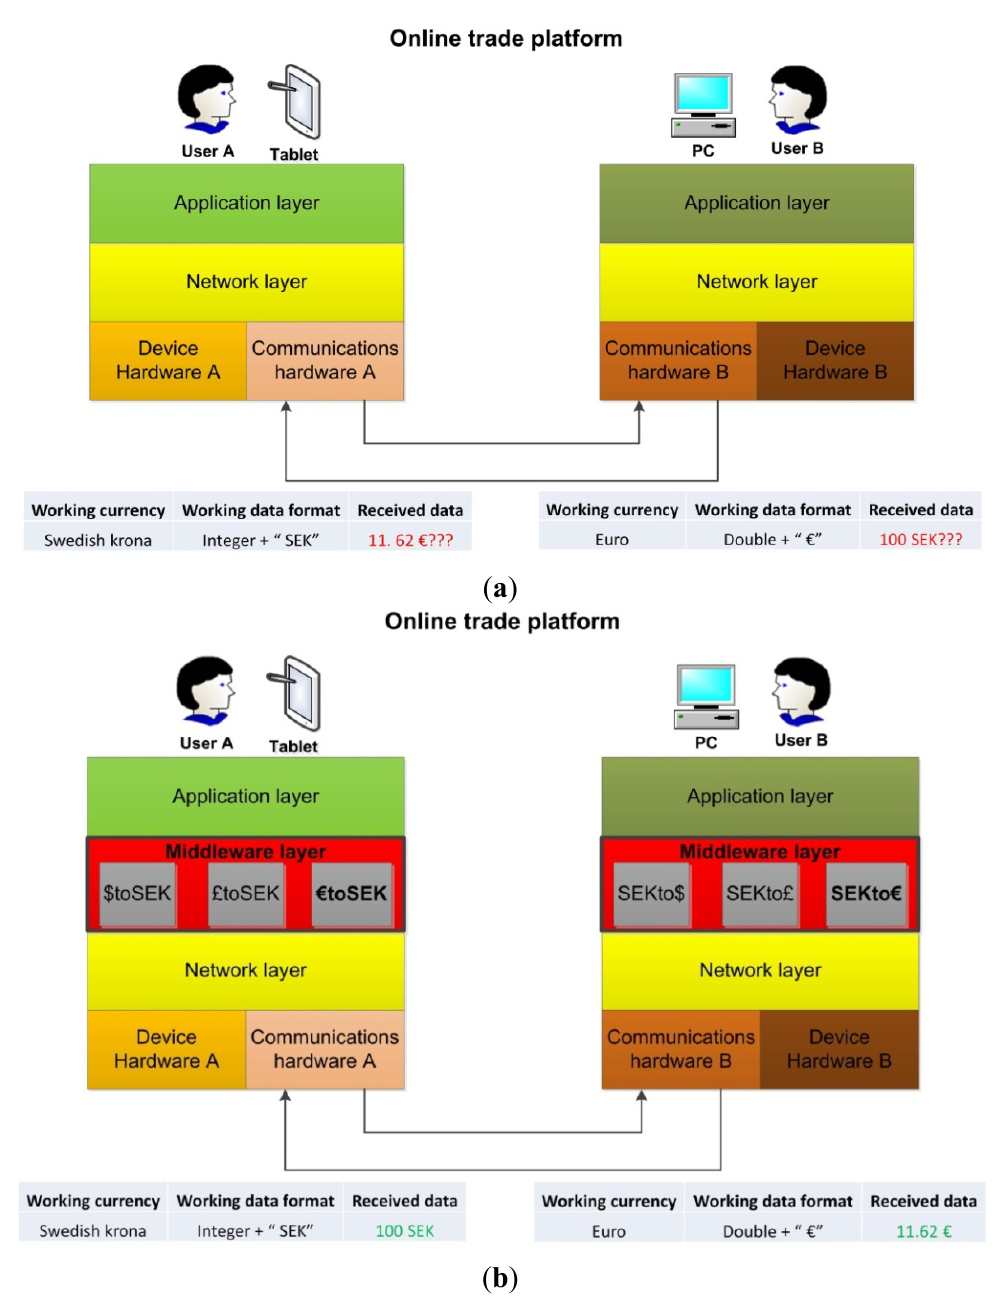
Figure 1. ( a ) Dissonance between the understandable data format and the one received; ( b ) Communications system enhanced with a middleware